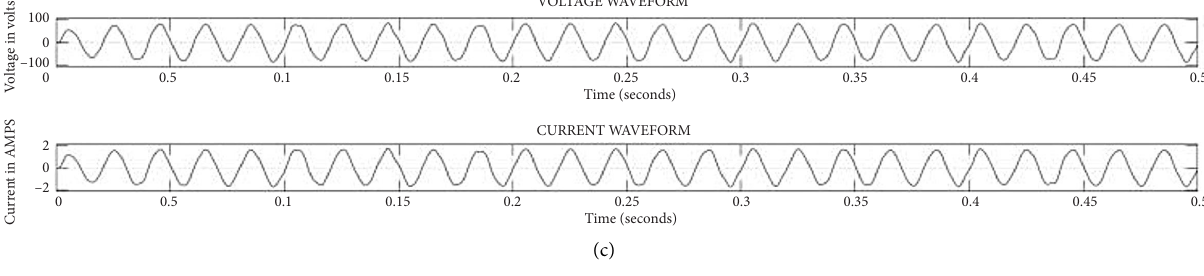
Figure 16: Output waveforms [17]. (a) Output waveforms for 50 V input. (b) Output waveforms for 75 V input. (c) Output waveforms for 100V input.